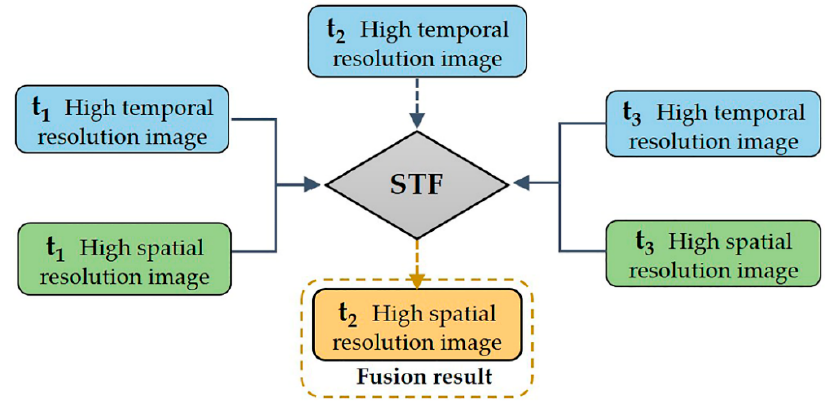
Figure 3. Schematic diagram of the spatiotemporal data fusion (STF) framework.